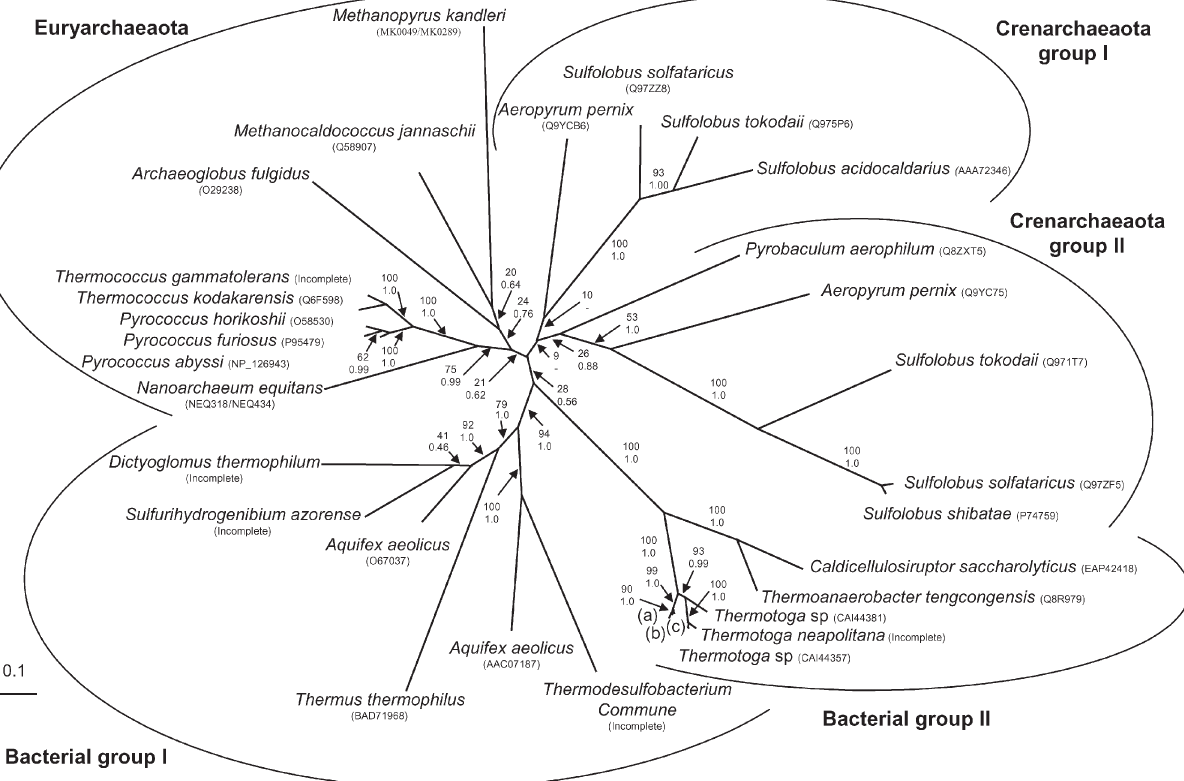
Figure 2. Maximum likelihood unrooted phylogenetic tree of reverse gyrase. The tree was calculated by PHYML (JTT model, gamma correction (eight discrete classes), an estimated alpha parameter and an estimation of the proportion of invariant positions). Numbers > 0 at nodes are boot- strap values calculated from 1000 replicates by PHYML and numbers < 0 are posterior probabilities computed by MrBayes. The scale bar repre- sents the number of substitutions per site, and (a) Thermotoga naphthophila (CA144289); (b) Thermotoga maritima (O51934); and (c) Thermotoga petrophila